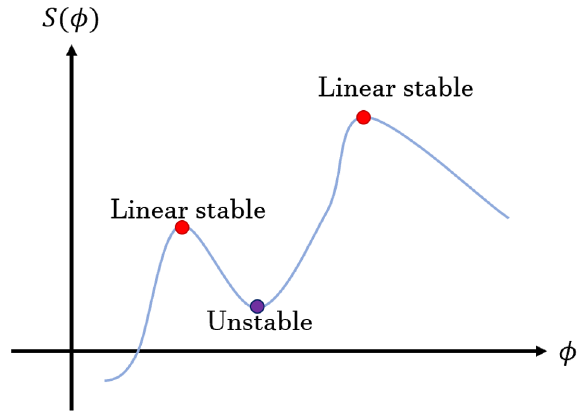
Figure 3. A sketch of entropy landscape with thermodynamic entropy being a function of scalar field configurations. The curve in light blue represents solutions to equations of motion. In specific, two red dots denote static solutions with linear stability, while the purple dot denotes a static solution that is